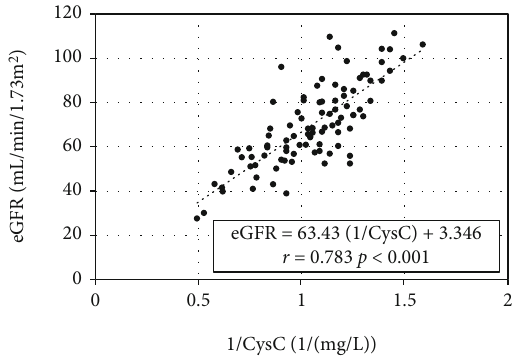
Figure 2: Correlation between 1/CysC and eGFR in T2DM. The correlation was calculated using the least-squares method. CysC; cystatin C; eGFR: estimated glomerular fi ltration rate; T2DM: type 2 diabetes